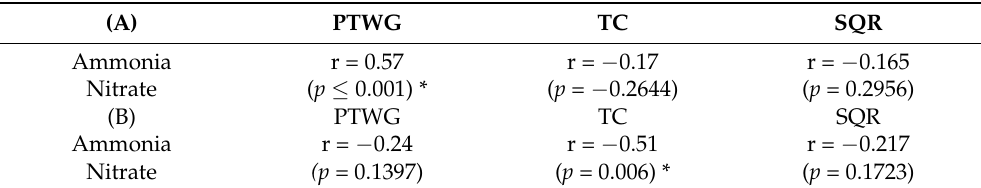
Table 2. Overall Pearson’s correlation coefficients (r) and probability of significance ( P ) between ammonia and nitrates concentrations in turnip plants (root and shoot) grown in soil treated with biochar (A) and soil not treated with biochar